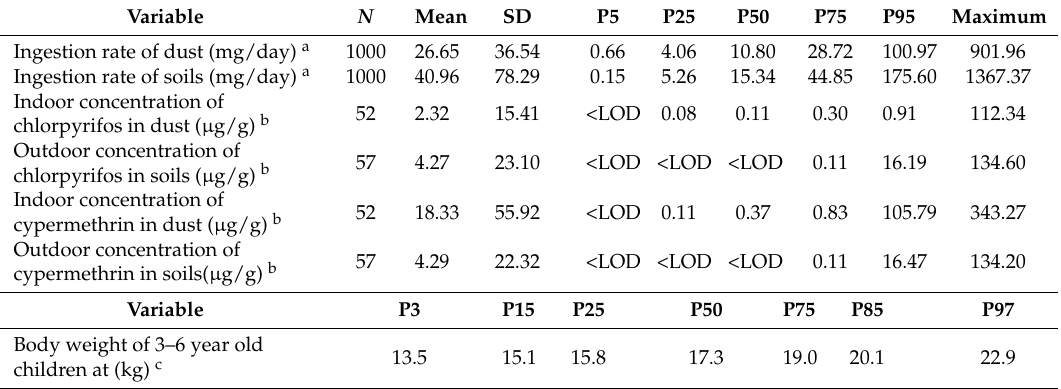
Table 1. Distributions of variables used in daily intake estimation for ingestion of dust and